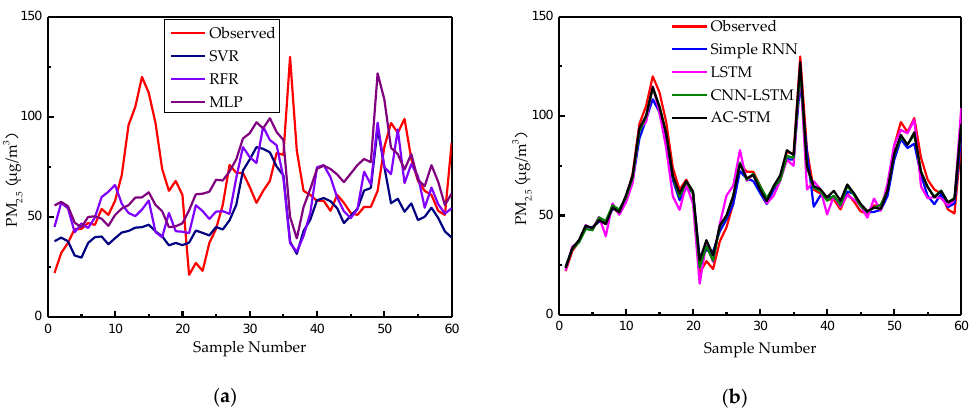
Figure A3. The results of all models in the 10-h PM 2.5 prediction: ( a ) SVR, RFR, and MLP; ( b ) simple RNN, LSTM, CNN–LSTM, and AC-LSTM.